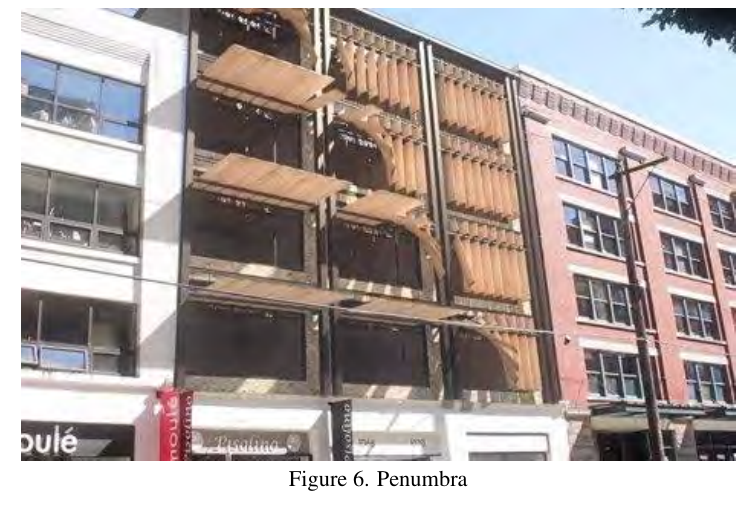
Figure 6. Penumbra